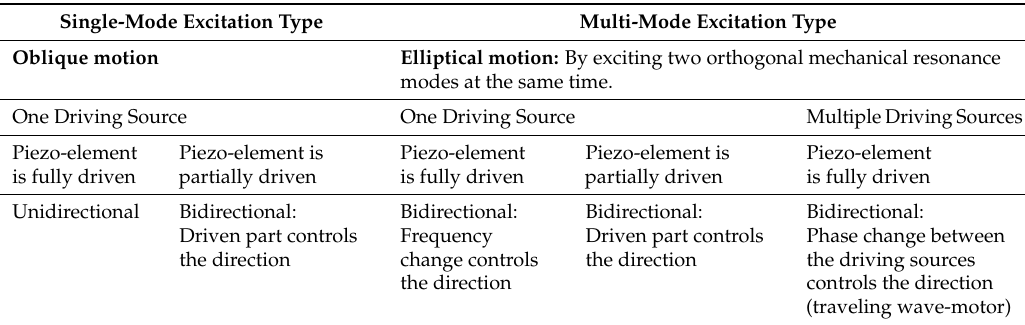
Table 1. Classification of resonance-drive type piezoelectric (ultrasonic) motors.